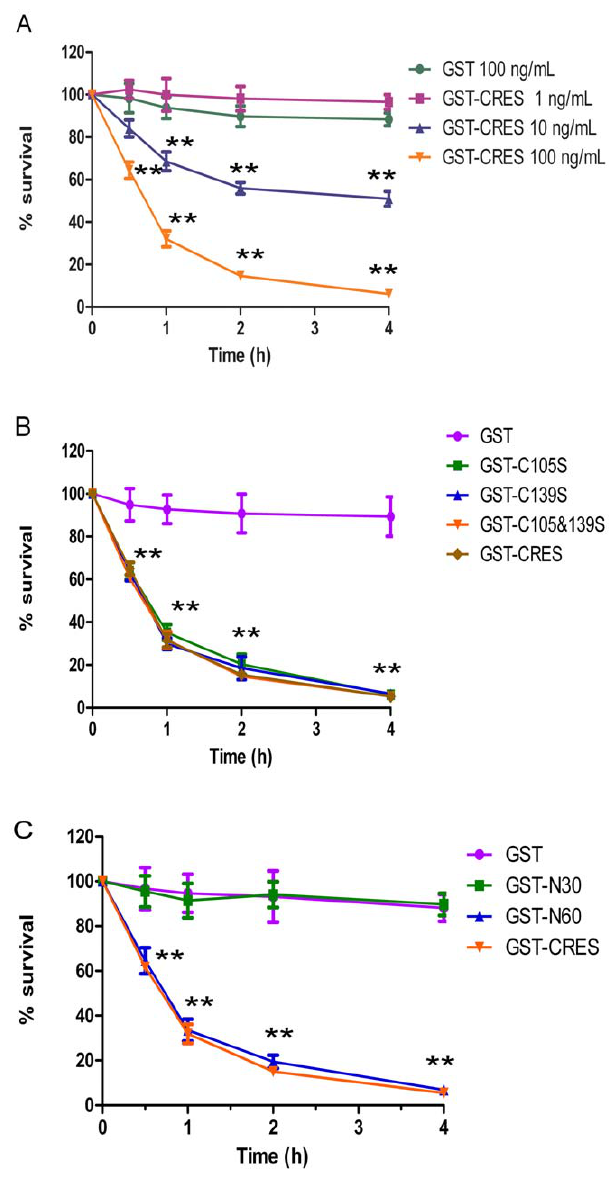
Figure 2. Antibacterial activities of CRES. (A) E. coli D5 a were incubated with 1 ng/mL (purple), 10 ng/mL (blue), 100 ng/mL